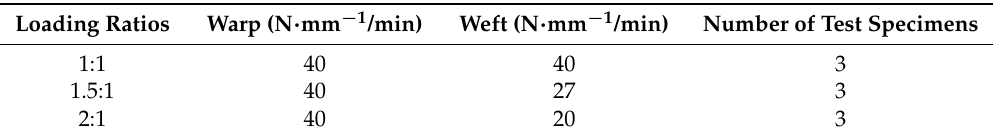
Figure 2. Biaxial test machine. Table 1. Layout of the experimental plan.